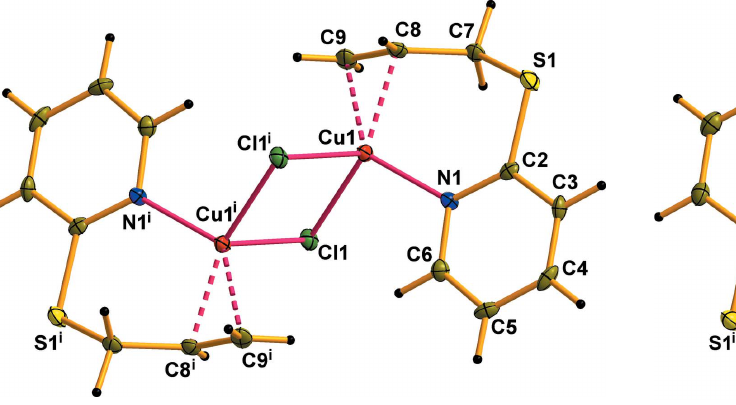
Figure 1 The molecular structure of I with displacement ellipsoids drawn at the 50% probability level. Symmetry code: (i) (cid:3) x + 1, (cid:3) y + 1, (cid:3) z +